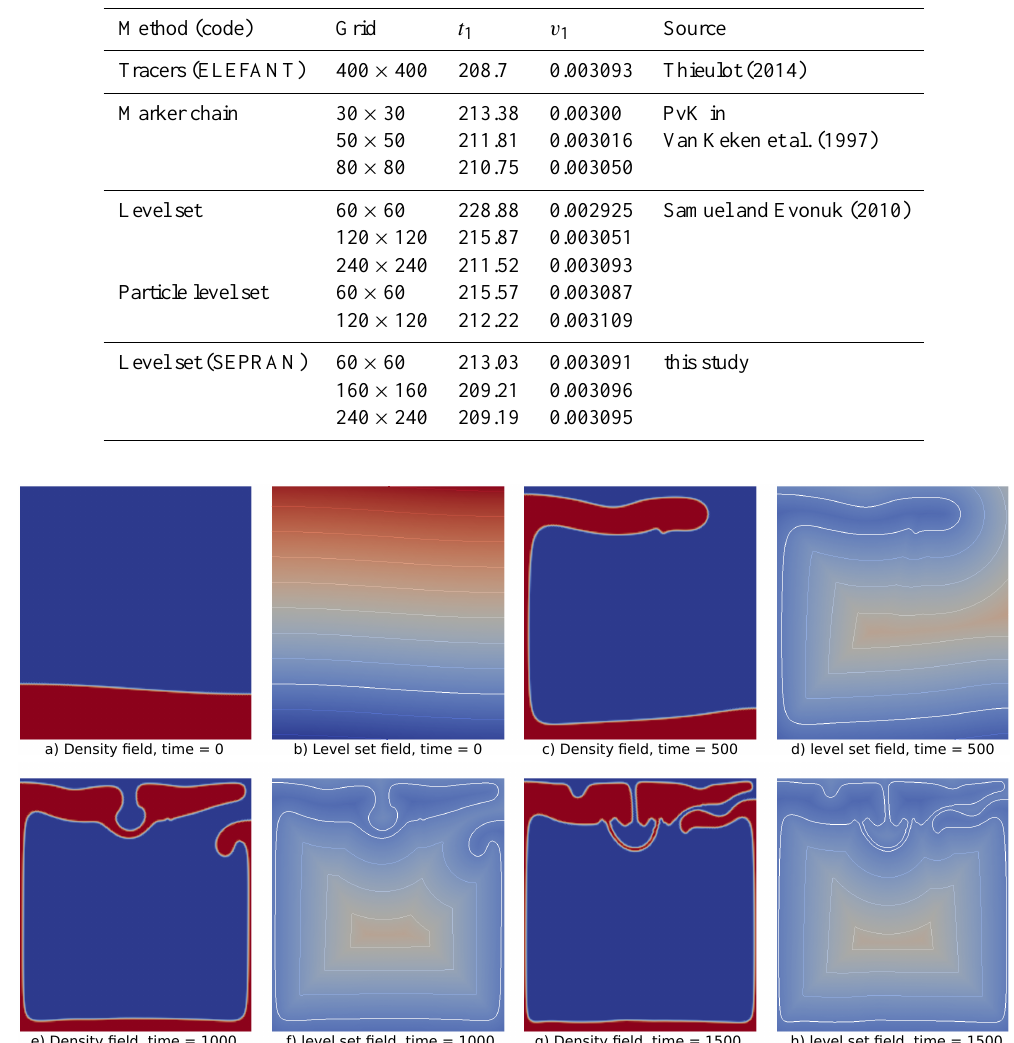
Figure 2. Snapshots of the evolution of the density field and the level set field with time. Level set isocontours are plotted every 0.1. The thick white line represents